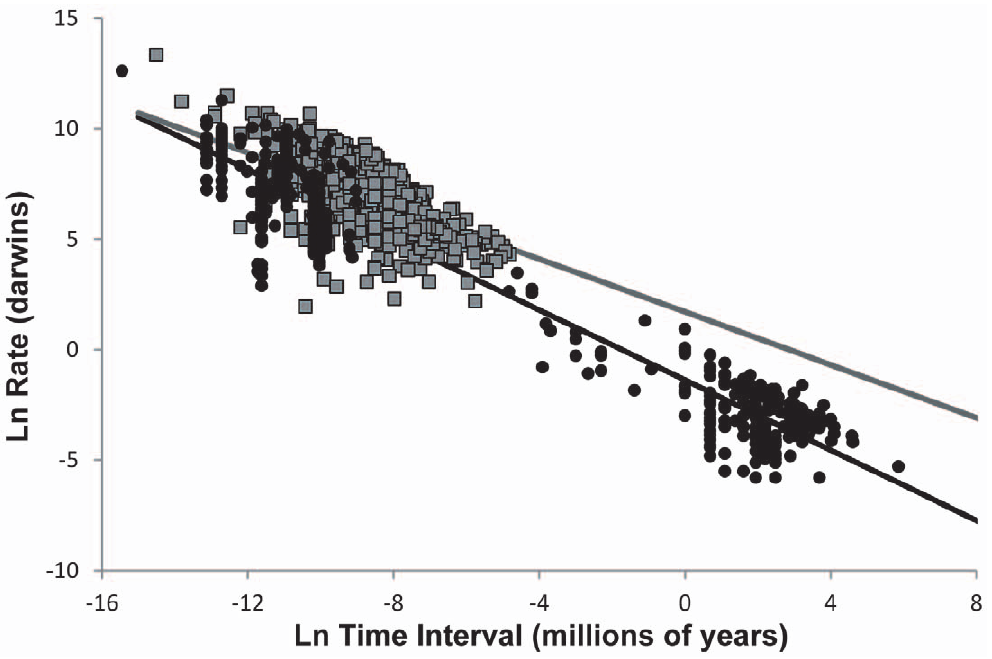
Figure 2. Biological rates and cultural rates plotted against the interval of time over which the rates are measured. Biological rates (black circles) and cultural rates (gray squares) are inversely correlated to the interval of the time over which the rates are measured. The solid lines represent the linear mixed model of interaction that best fit the biological (black line) and cultural (gray line) distributions (Table 2).